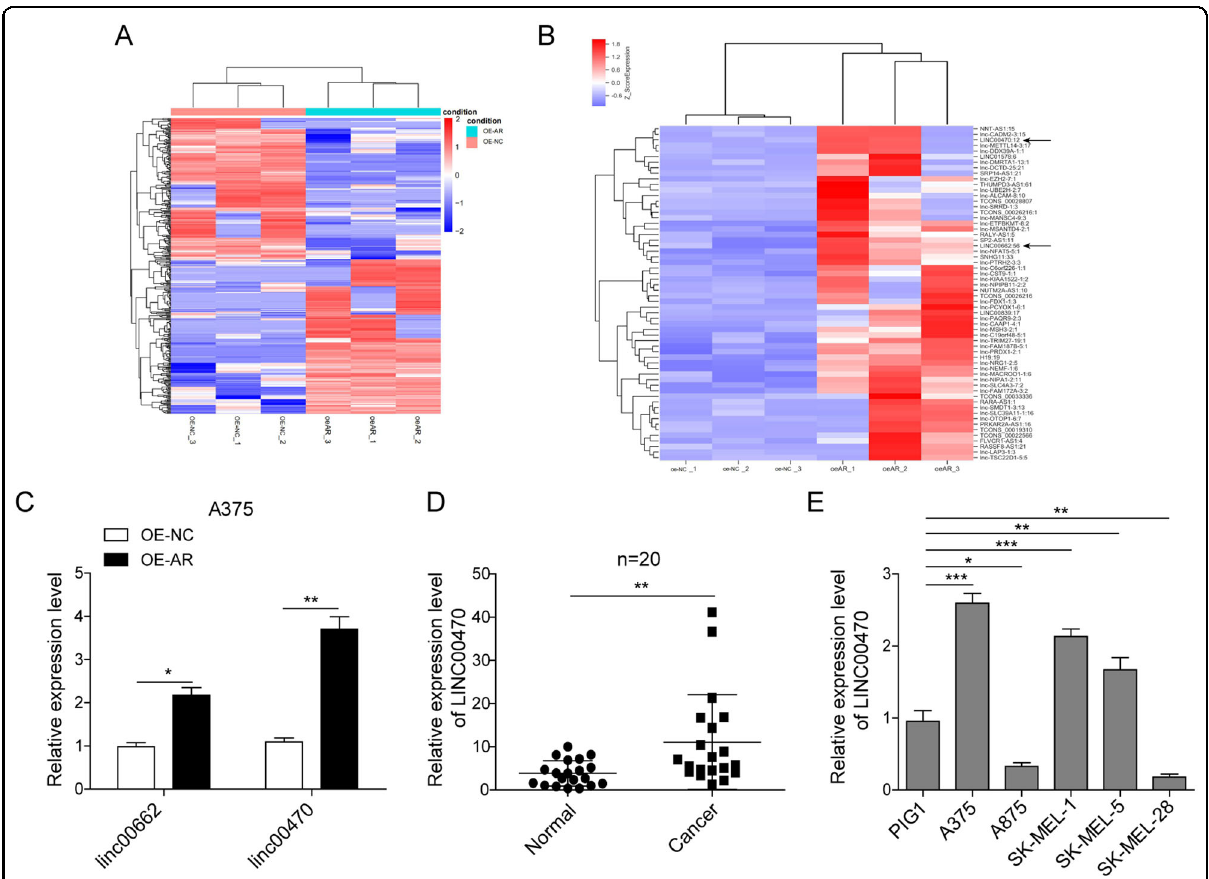
Fig. 2 LINC00470 was upregulated in the AR-overexpressed A375 cells. A , B Heatmap generated by LncRNA sequencing from A375 cells and AR-overexpressed A375 cells. C The expression of LINC00662, and LINC00470 were analyzed in the A375 cells and AR-overexpressed A375 cells using qRT-PCR. D Expression of LINC00470 in the normal and melanoma tissues ( n = 20) analyzed by qRT-PCR. E The expression of LINC00470 in different cell lines was quanti fi ed by qRT-PCR. The mean ± SD in the graph shows the relative levels from three replicates. *p < 0.05, ** p <